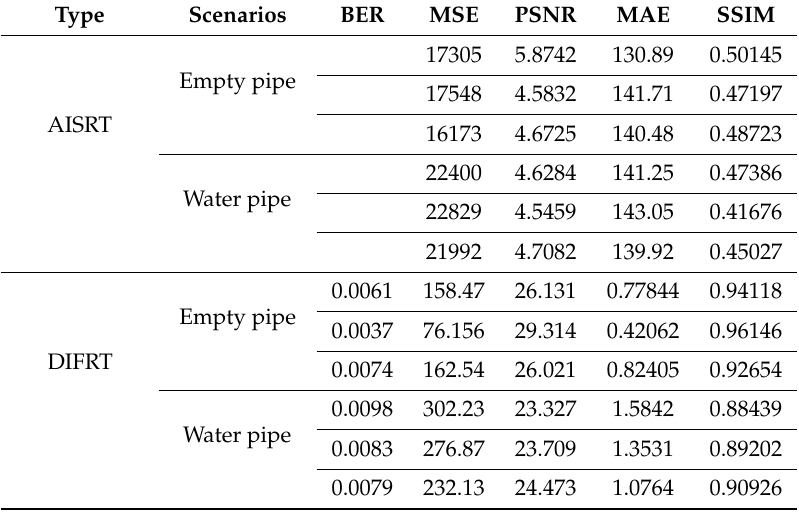
Table 2. Comprehensive performance comparison between DIFRT and AISRT for the final